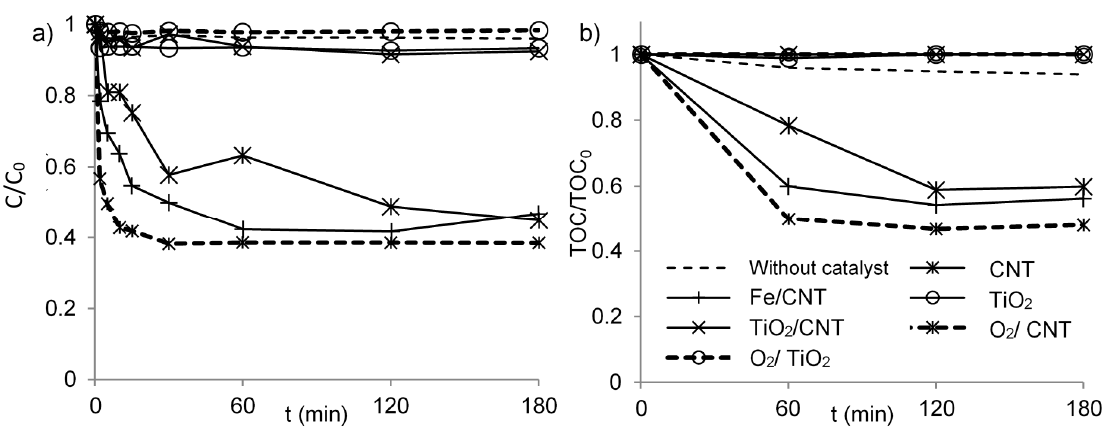
Figure 3. Dimensionless SMX ( a ) and TOC ( b ) concentration during H 2 O 2 catalytic oxidation and adsorption experiments (O 2 ) on CNT, Fe/CNT, TiO 2 , and TiO 2 /CNT.